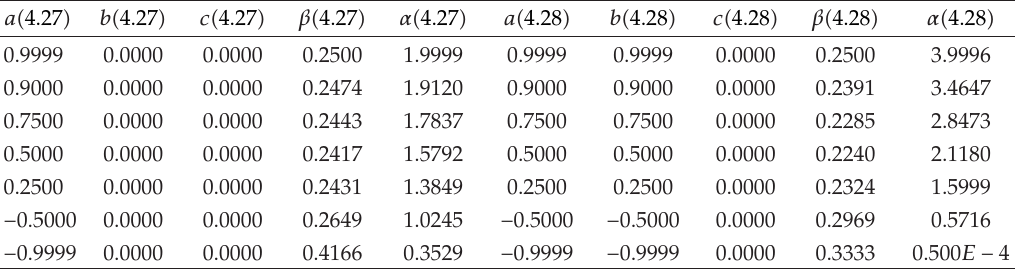
Table 2: Stability intervals of LMMs (cid:3) 4.27 (cid:4) and LMMs (cid:3) 4.28 (cid:4)